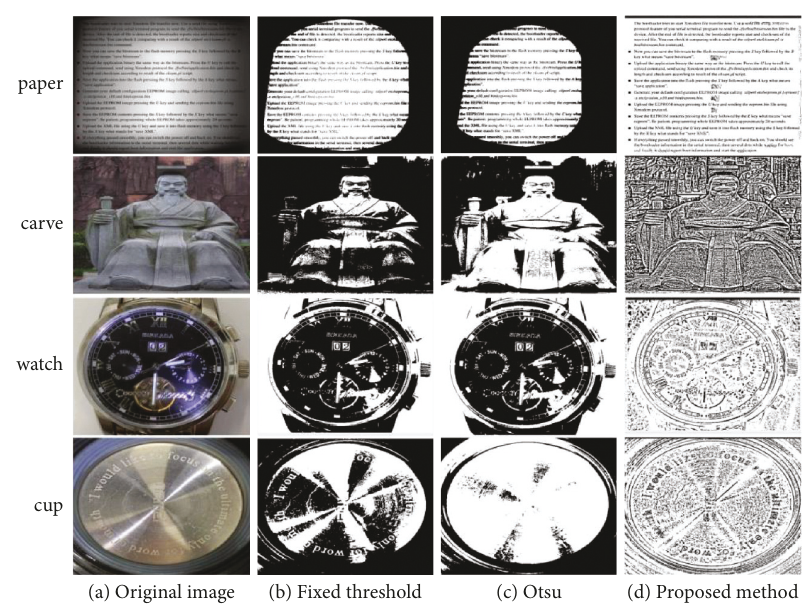
Figure 9: Experiment comparison of various algorithms.